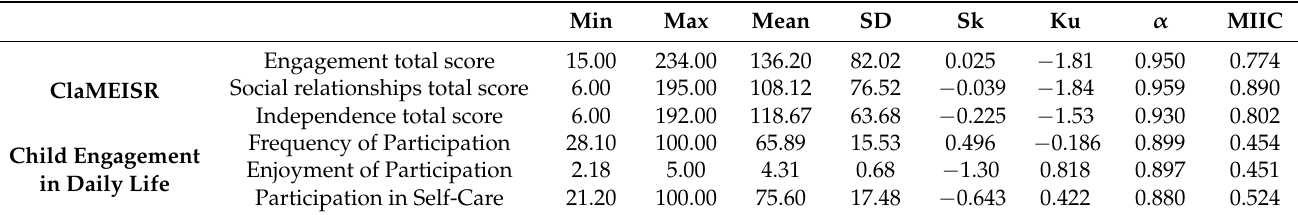
Table 2. Descriptive Statistics and Alpha ( α ) Reliabilities for the Used